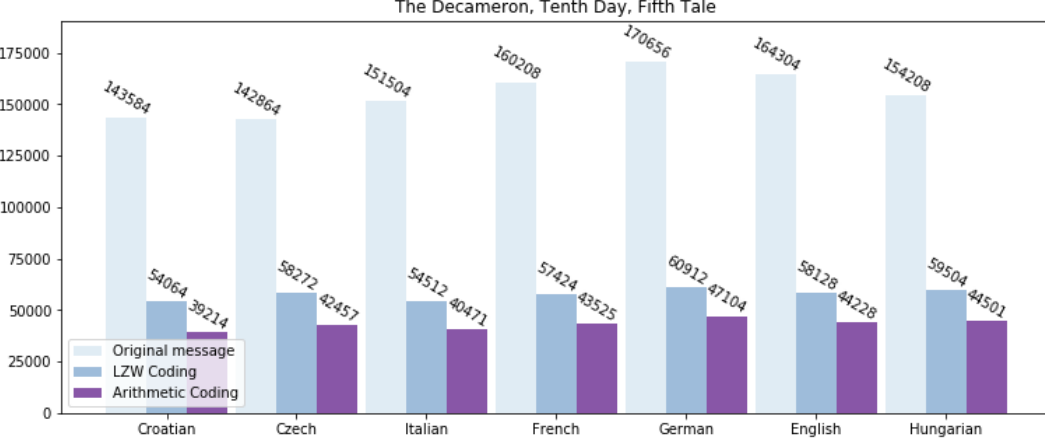
Figure 4. Encoding The Decameron Tale.